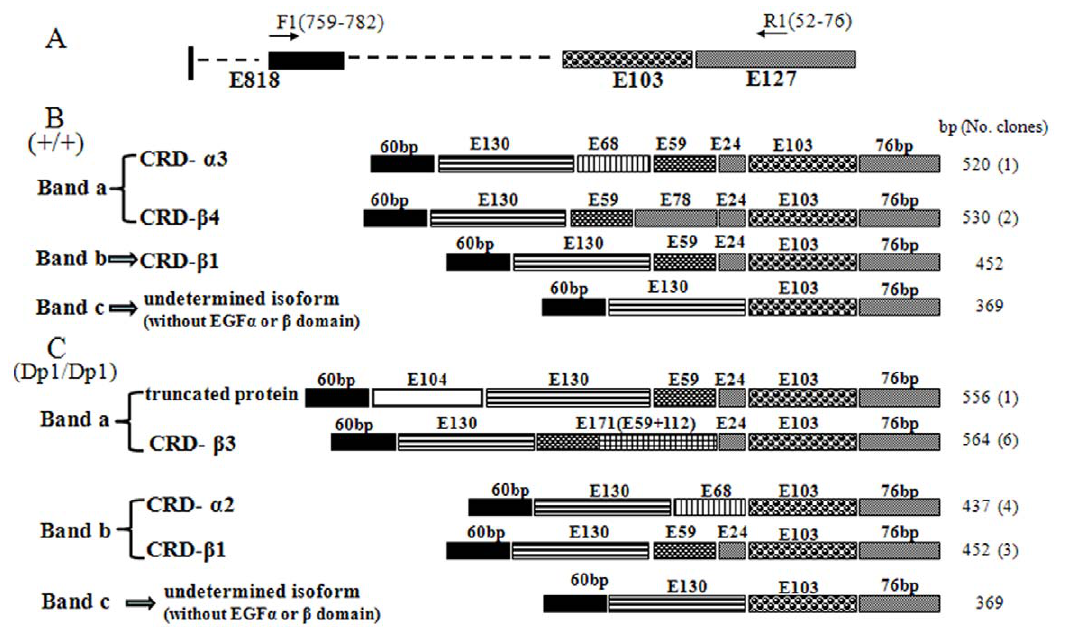
Figure 4. Transcripts of CRD-Nrg1 and the expected protein isoforms in wild-type and Dp1/Dp1 homozygous mice. (A) RT-PCR amplified region of CRD-Nrg1 transcripts. The primers used for RT-PCR are indicated; the arrow indicates the approximate primer position within the exon. (B) Transcripts of CRD-Nrg1 produced by wild-type mice. (C) Transcripts of CRD-Nrg1 produced by Dp1/Dp1 homozygous mice. In band a, one transcript contains a new exon, E104 (which is expected to produce a truncated protein without the EGFc, EGF b , and EGF a domains), and another transcript (accounting for 6/7 of the clones) transcribes through exon E59 into the adjacent 112 bp sequence (which is expected to produce CRD- b 3 type isoforms). In band b, one transcript (accounting for 4/7 of the clones) bypasses the mutated splice donor site by splicing over exon E59 (which is expected to produce CRD- a 2 type isoforms).